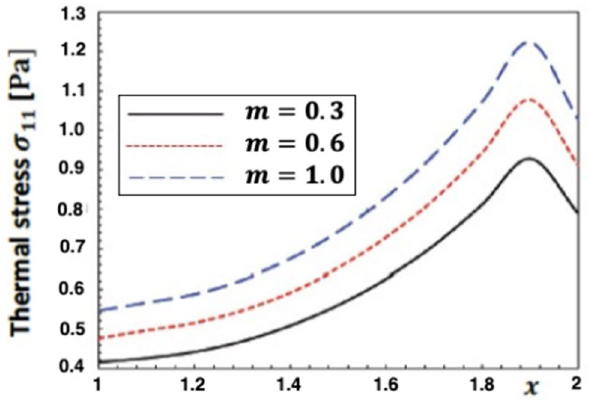
Figure 6. Variation of the thermal stress σ 11 along x -axis for different values of functionally graded parameter.